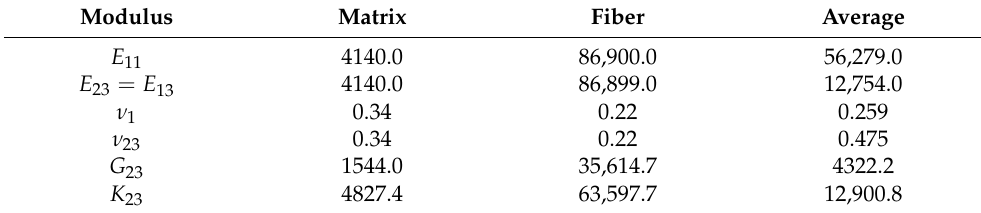
Table 6. Computed values of the elastic moduli (Case 3).